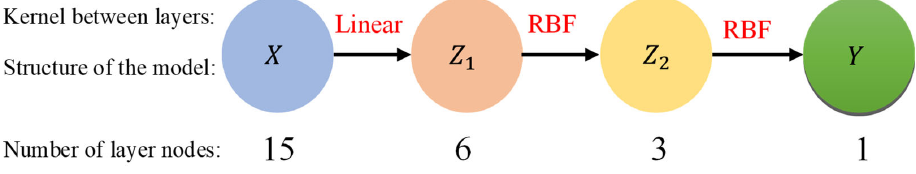
Figure 6. Structure diagram of the rotation error prediction model.